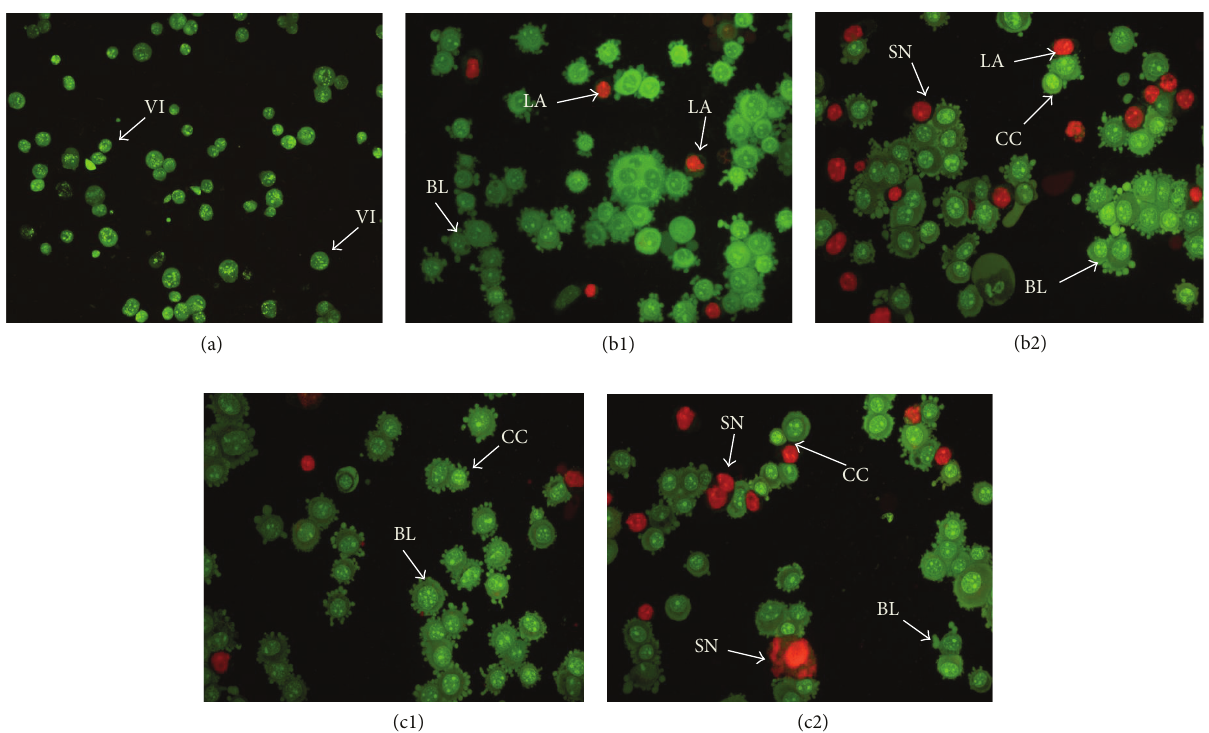
Figure 11: Fluorescent micrographs of AO/PI-double-stained MCF-7 cells. (a) Untreated MCF-7 cells exhibit normal structures. (b1) and (c1) Early apoptosis features, namely, blebbing and chromatin condensation as well as late apoptotic cells, were detected after 24 h of treatment with (1) and (2). (b2) and (c2) Late apoptosis and secondary necrosis were obsereved after 48 h of treatment with (1) and (2), respectively (magnification: 200x). VI: viable cells; CC: chromatin condensation; BL: blebbing of the cell membrane; LA: late apoptosis; SN: secondary necrosis.